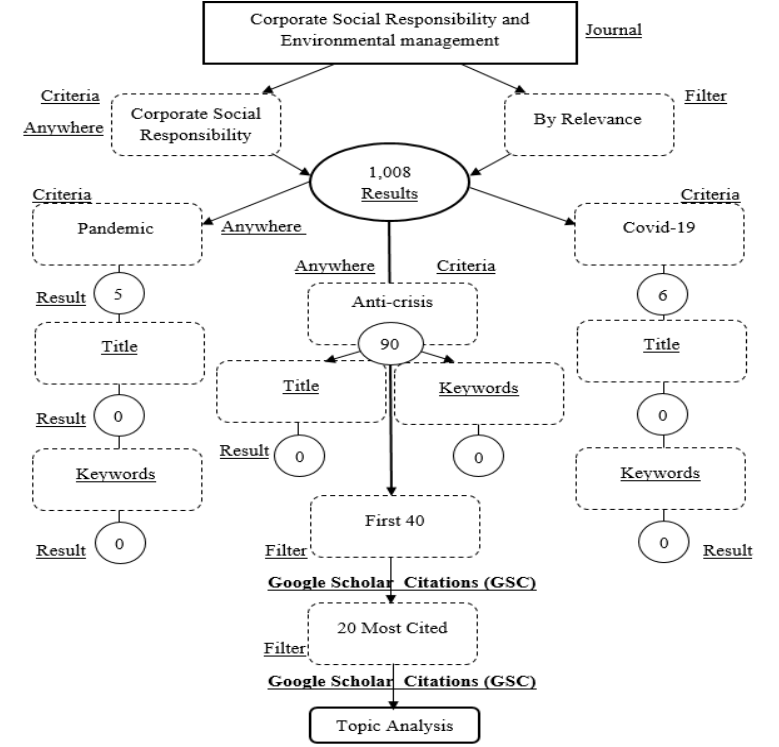
Figure 1: CSR&EM Gap